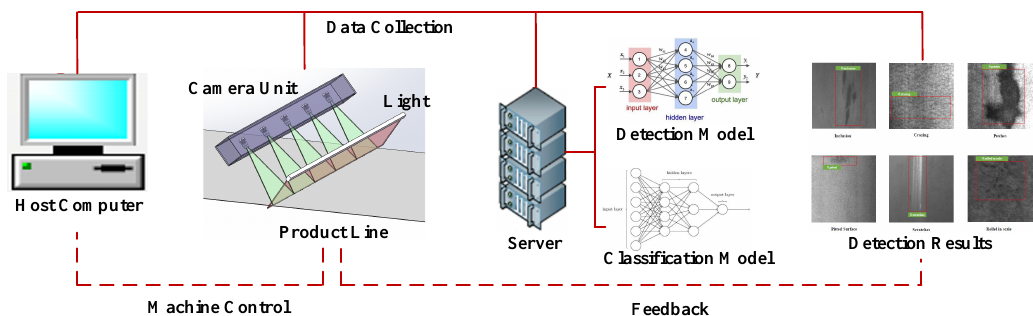
Figure 2. Overview of our industrial system. Our industrial system consists of host computers, production lines, servers, and detection results. The host computer is to control the operation of the entire system while the server is to deploy a defect detection model for the production line. Finally, detection results provide feedback for the production